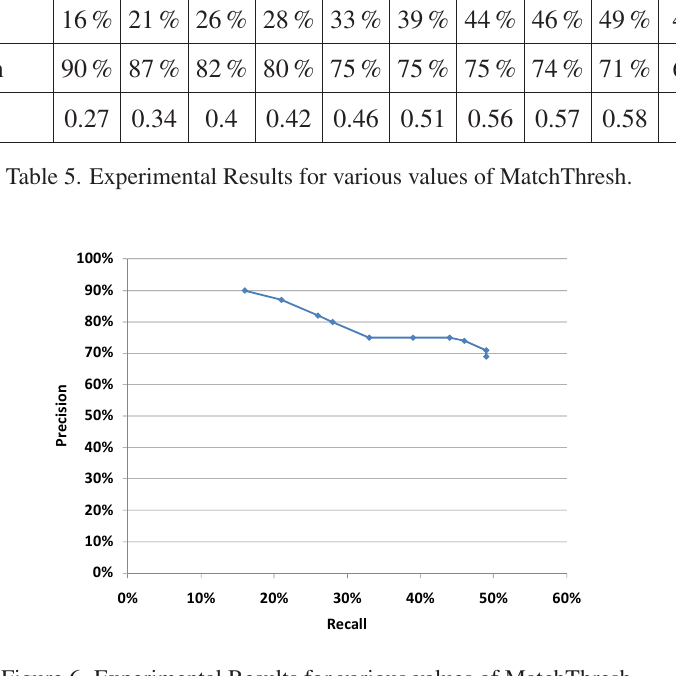
Figure 6. Experimental Results for various values of